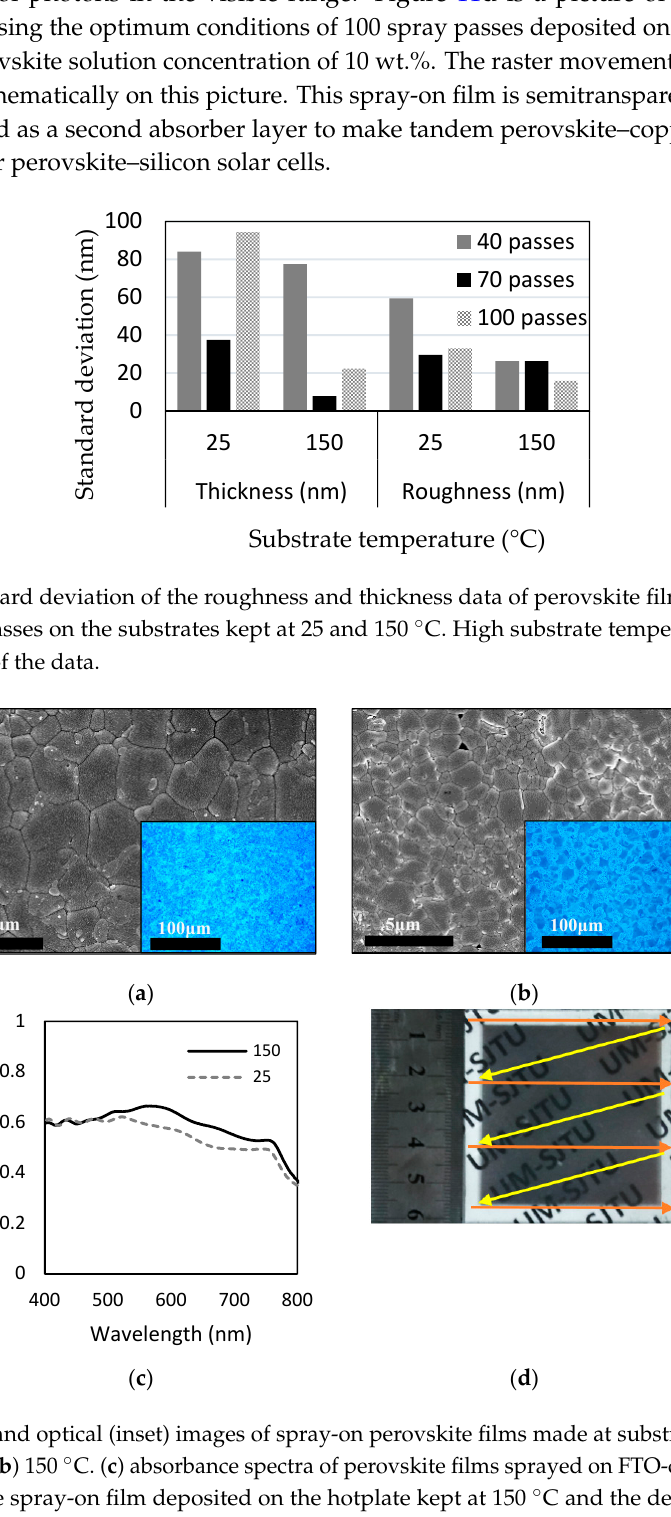
Figure 9. SEM images of spray-on perovskite films deposited on FTO-coated glass substrates at substrate temperatures of 150 °C. The number of spray passes are ( a ) 40; ( b ) 70; and ( c ) 100. Letter C refers to the percentage of coverage of perovskite layer on the substrates.